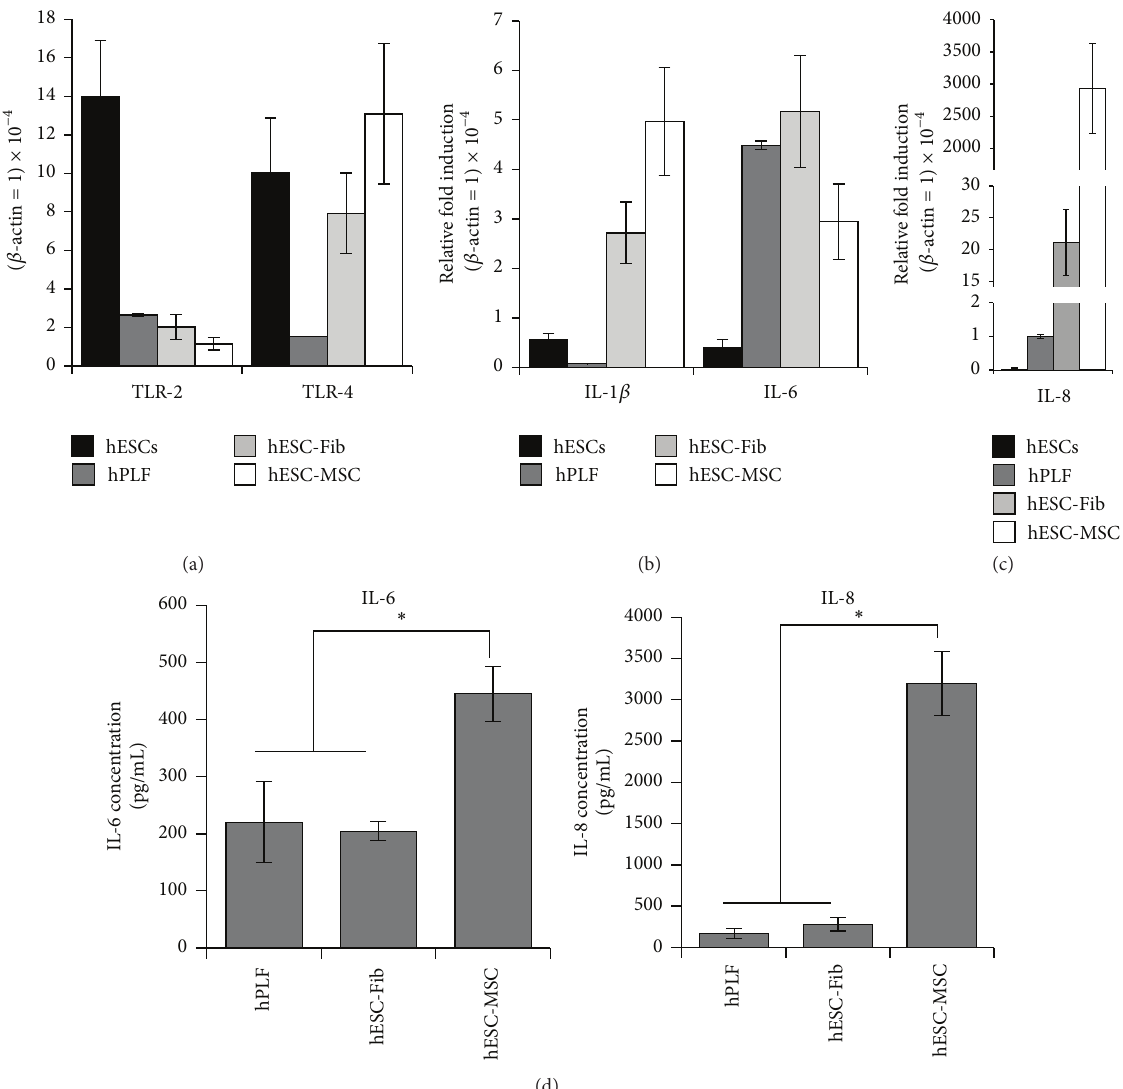
Figure 4: Basal expression profiles of TLR and cytokines in hESCs, hPLFs, hESC-Fib, and hESC-MSCs. Basal expression profiles of (a) TLR-2 and TLR-4 and (b, c) IL-1 𝛽 , IL-6, and IL-8 among hESCs, hPLFs, hESC-Fib, and hESC-MSCs as analyzed by real-time RT-PCR. The relative fold induction is relative to the respective transcript levels of 𝛽 -actin. The 𝑦 -axis in (c) is broken to enable visualization of the relative expression levels of IL-8 among the different cell types. (d) Basal levels of cytokine production in the culture supernatants (assayed using ELISA) from hPLFs, hESC-Fib, and hESC-MSCs. The production of IL-6 and IL-8 by hESCs was below detection limits. Values represent the means ± SD of three experiments ( ∗ 𝑝 < 0.05